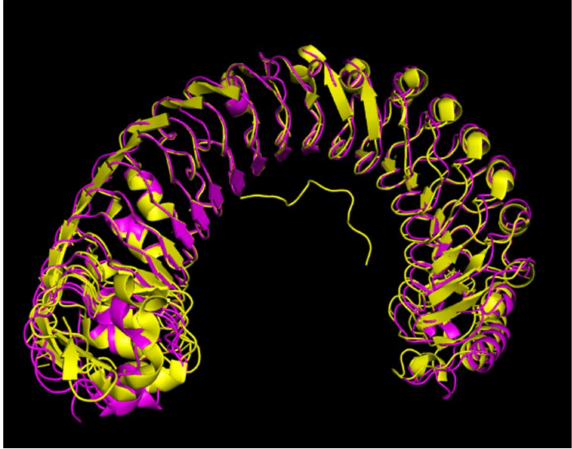
Figure 5. Alignment of the 3-D structures of VaHAESA and Arabidopsis thaliana HAESA (AtHAESA)